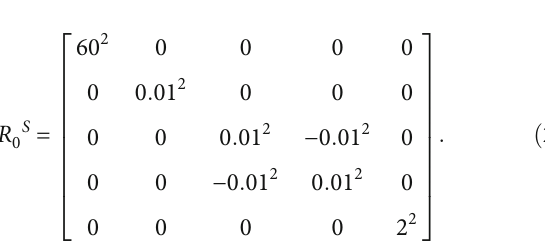
Figure 7: Trajectory of azimuth mutation (uniform variable).